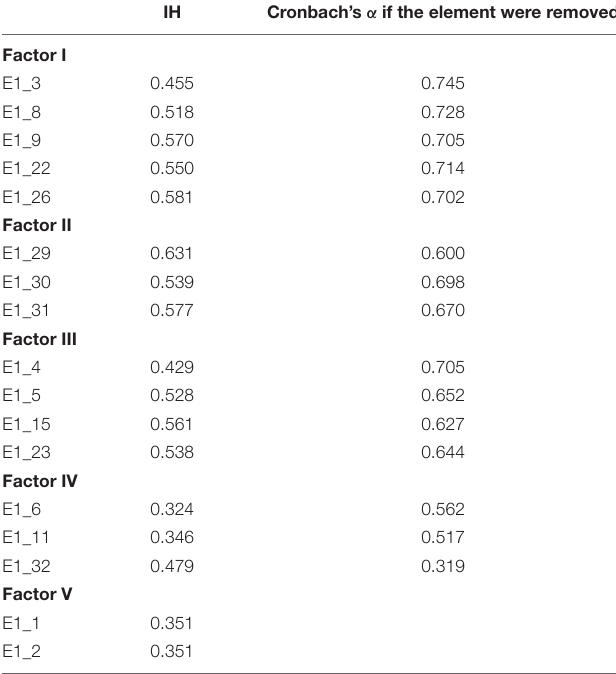
TABLE 3 | Index of homogeneity